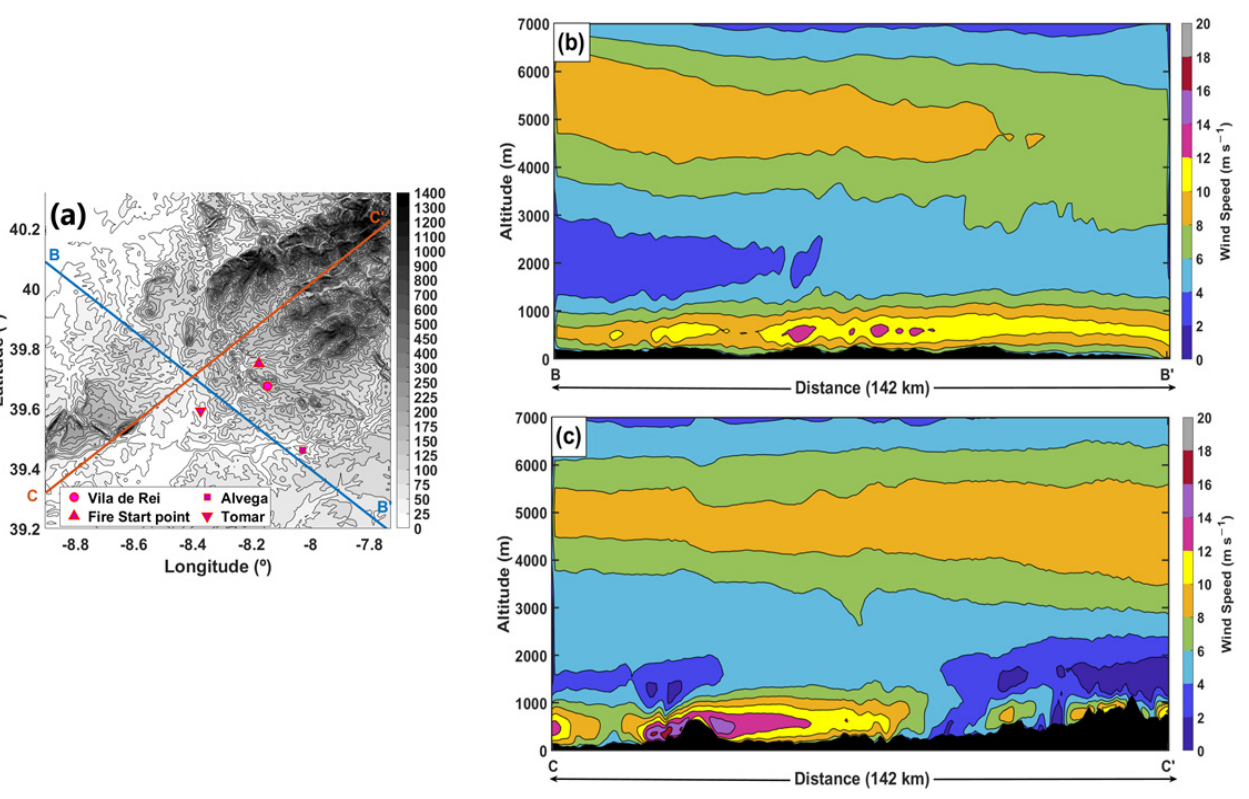
Figure 7. ( a ) Orography of the regional area; ( b ) Vertical cross-sections of the wind speed (m s − 1 ) by EXP simulation on 20 July 2019 at 2200 UTC along B–B’; ( c ) and C–C’. The near-surface wind gusts and direction at the local burned area on 20 July 2019 are shown in Figure 8. The wind direction at 10 m is predominantly from the northwest during the entire period. It is noteworthy that the near-surface wind gusts in Vila de Rei’s wildfire vary from 10 m s − 1 up to 12.5 m s − 1 at 1500 UTC, with the maximum up to 15 m s − 1 (Figure 8a). The maximum wind speed of 15 m s − 1 is found at 1800 UTC in the southeast of Vila de Rei (Figure 8b). Figure 8c, corresponding to 2100 UTC, indicates some locales southeast of Vila de Rei with the maximum wind values corresponding to the zone